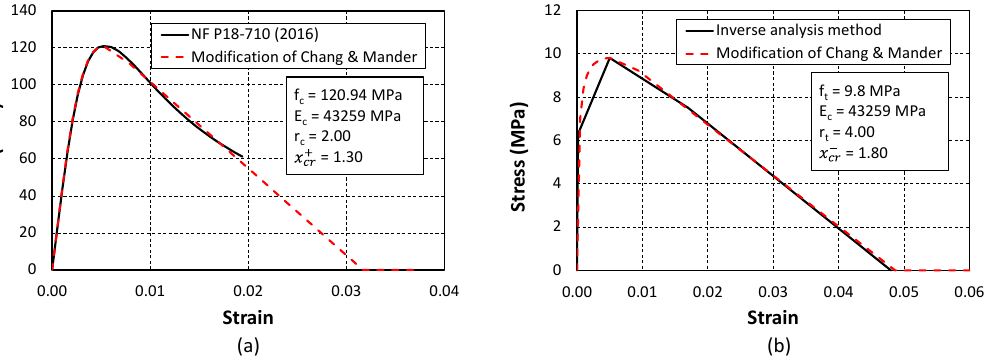
Figure 6. Example of the constitutive curve of concrete for UHPC (modi fi cation of Chang and Mander’s model [59]) for HCV02C: ( a ) compression envelope; ( b ) tension envelope.